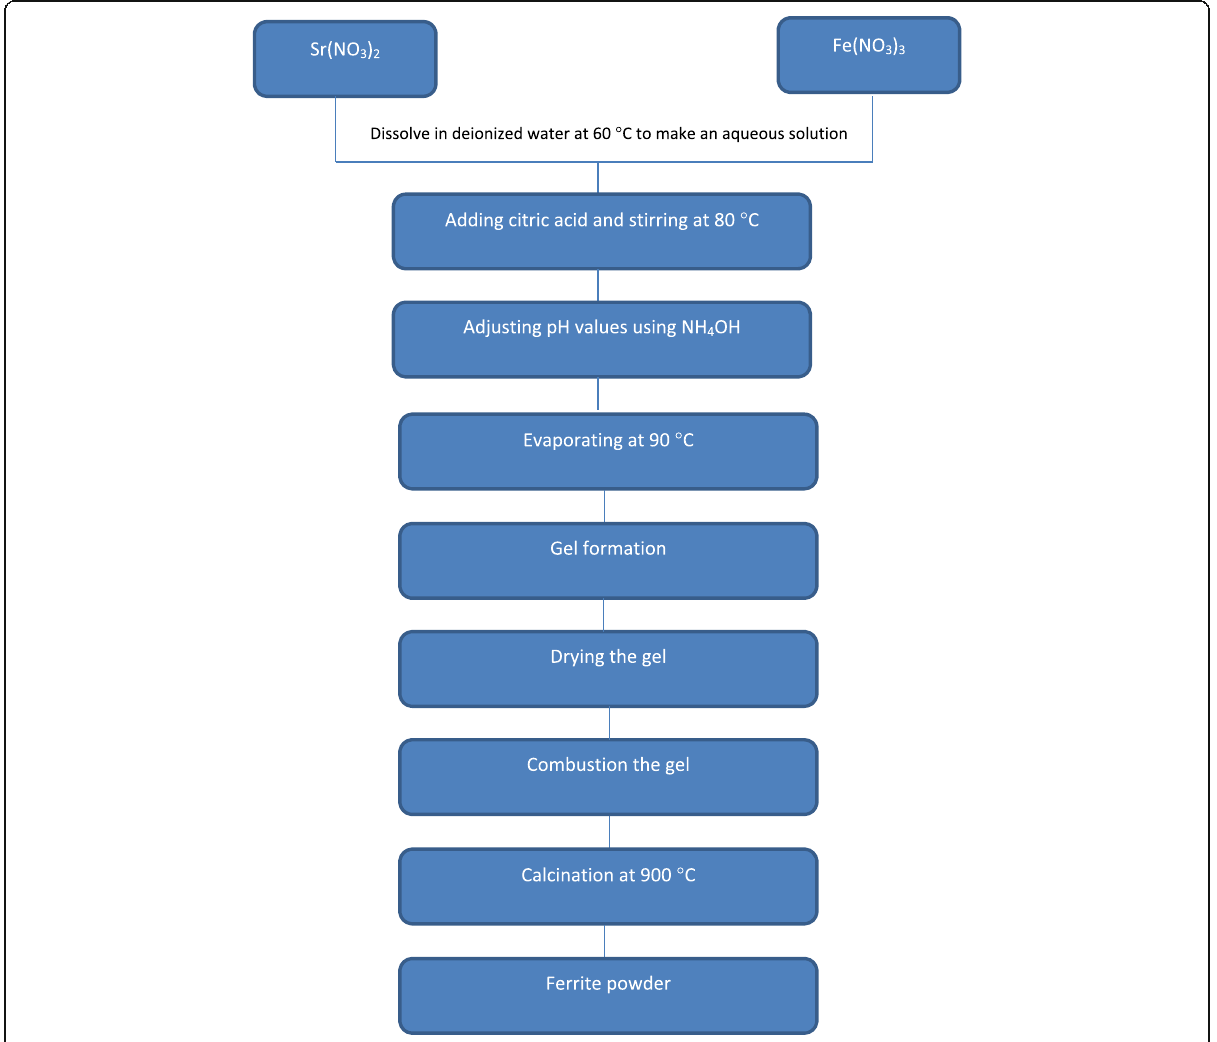
Fig. 1 Flowchart for preparing SrFe 12 O 19 nanoparticles powders by sol – gel